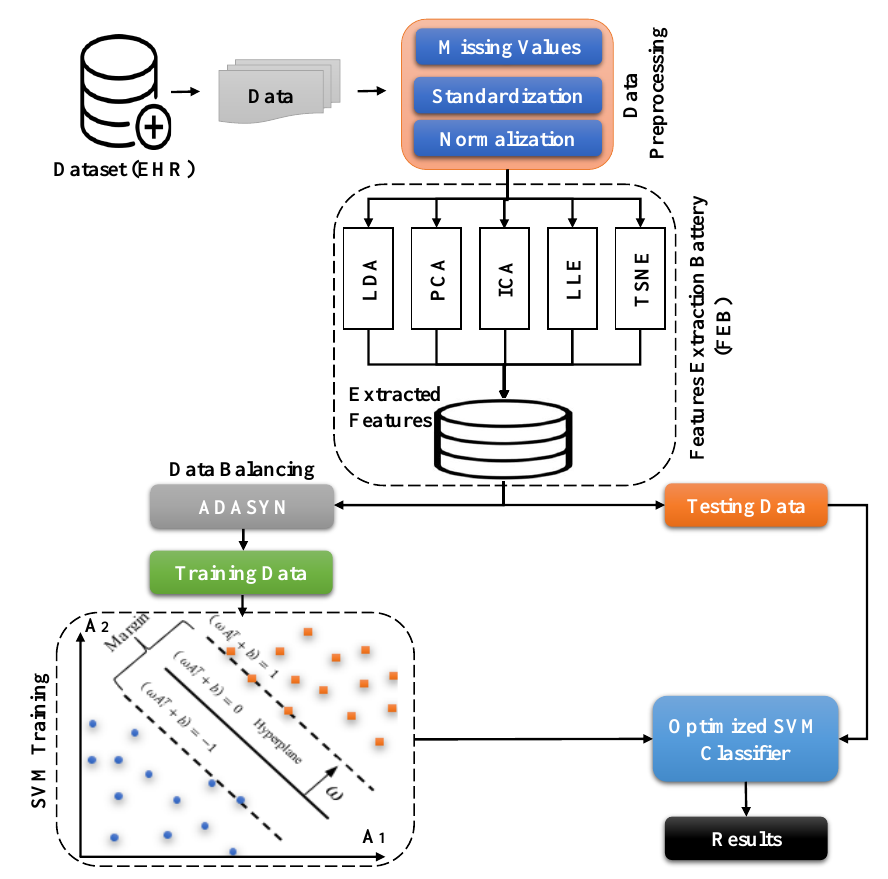
Figure 1. Schematic overview of the proposed model